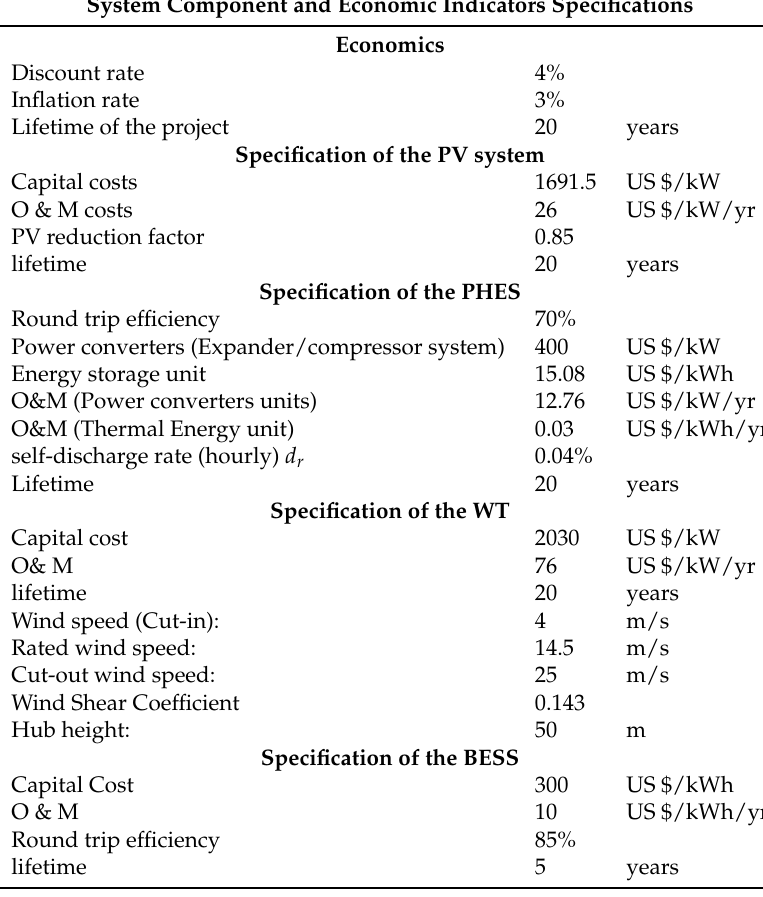
Table 1. Technical, Cost & lifetime parameters of the system components.